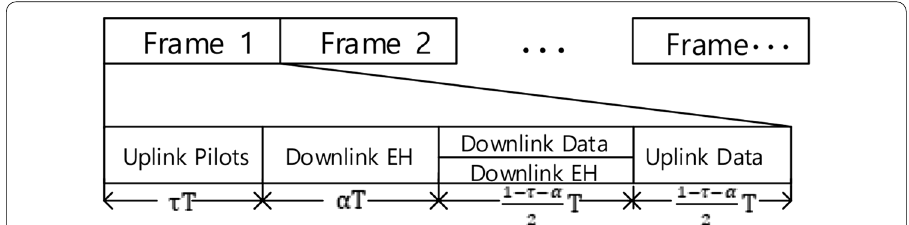
Fig. 2 A general transmission frame structure for the hybrid wireless EH